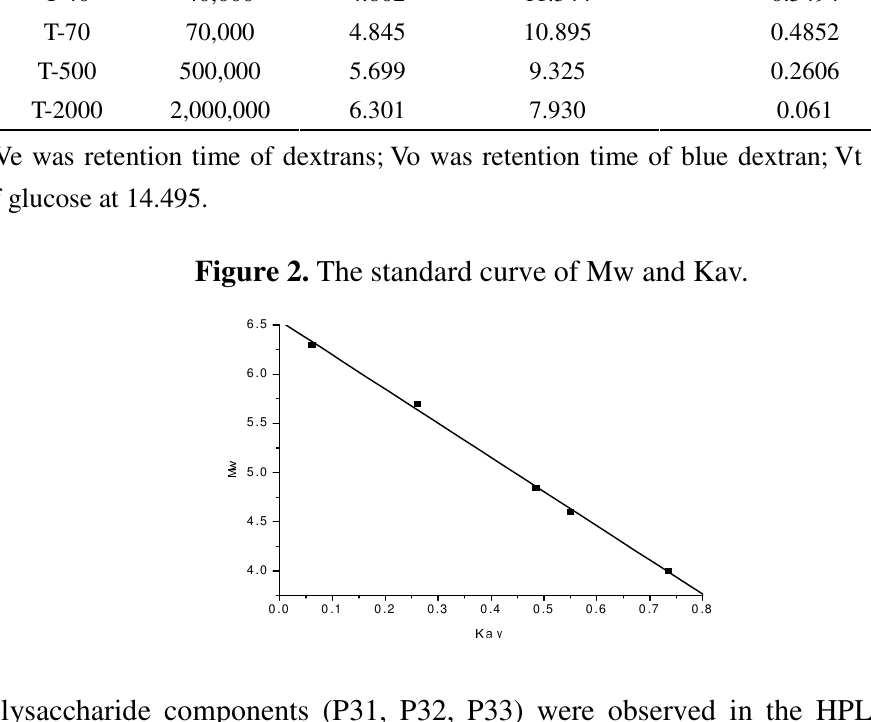
T-2000 (F), blue dextran (G), PV (H). T-10, T-40, T-70, T-500 and T-2000 correspond